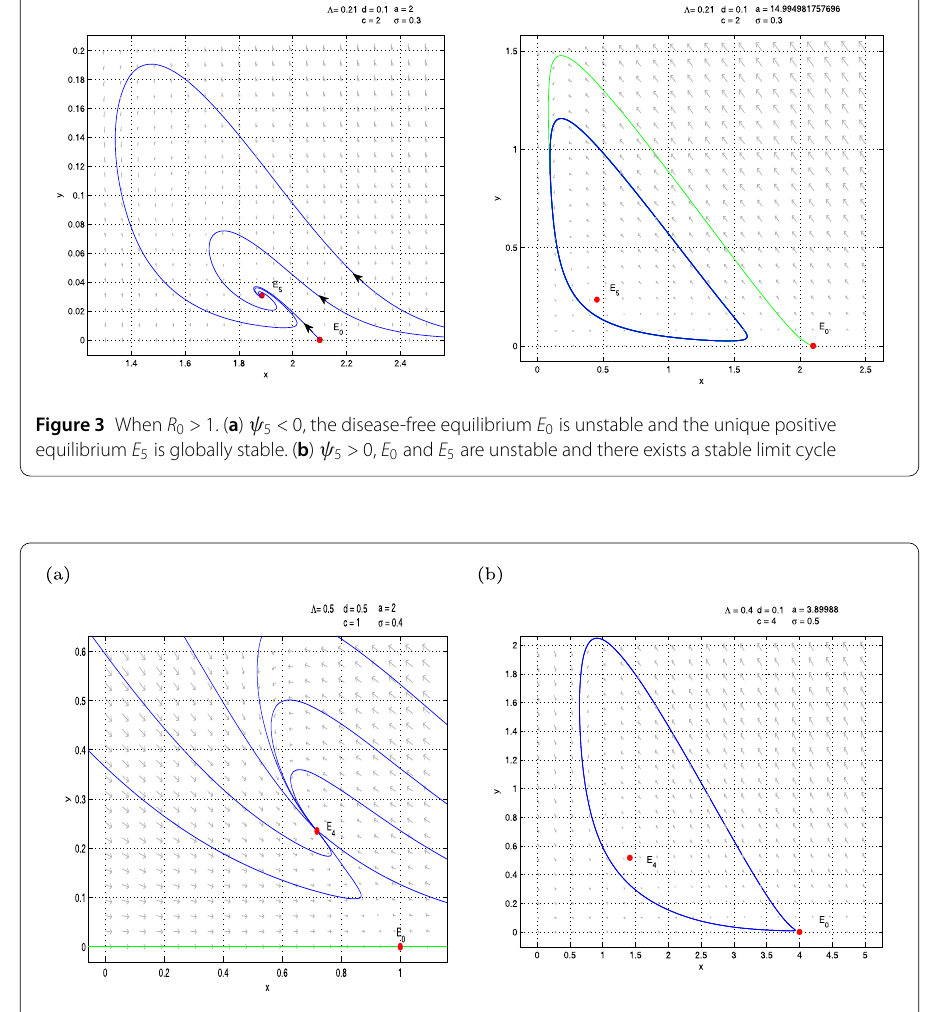
Figure 4 When R 0 = 1, and Λ > (1 – σ )/ a . ( a ) ψ 4 < 0, the disease-free equilibrium E 0 is unstable and the unique positive equilibrium E 4 is globally stable. ( b ) ψ 4 > 0, E 0 and E 4 are unstable and there exists a stable limit